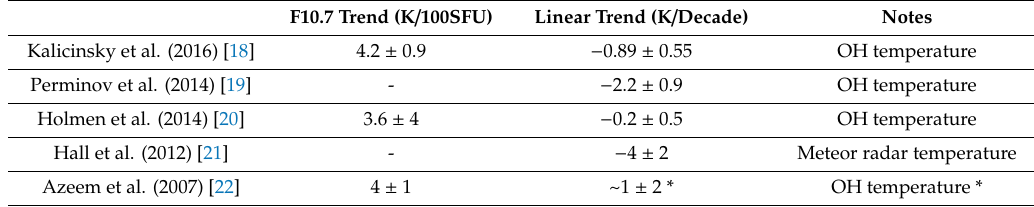
Table 2. A list of F10.7 trends and linear trends from previous